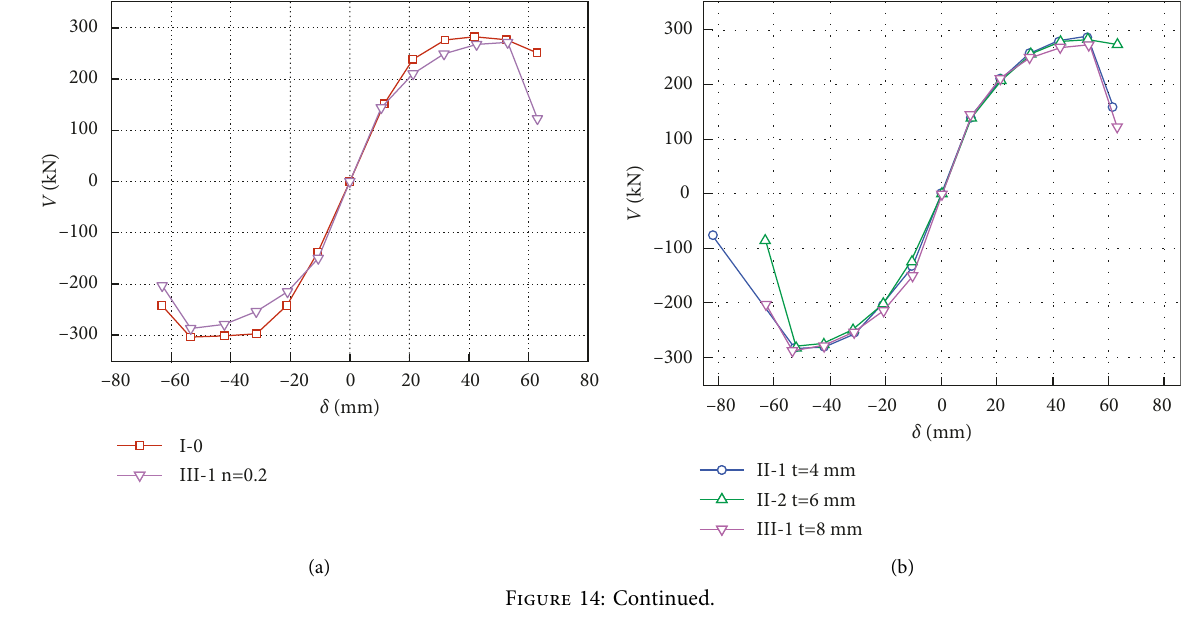
� 4mm). (c) Specimen II-2 ( n � 1